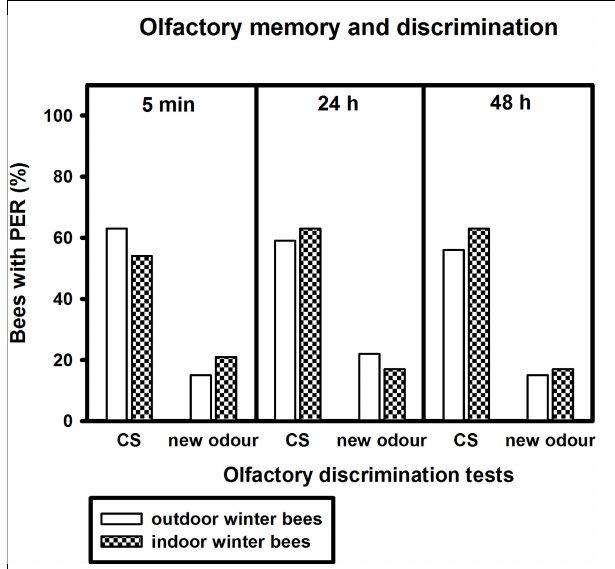
FIGURE 6 | Olfactory memory and discrimination of outdoor winter bees and indoor winter bees. The x -axis displays the tested stimuli (conditioned odour carnation (CS) or new odour cineole) at 5 min, 24 h or 48 h after conditioning. The y -axis shows the percentage of bees displaying the proboscis extension response (PER). For statistics see text. The same individuals as in Figure 5 are displayed minus individuals that did not survive the 48-h